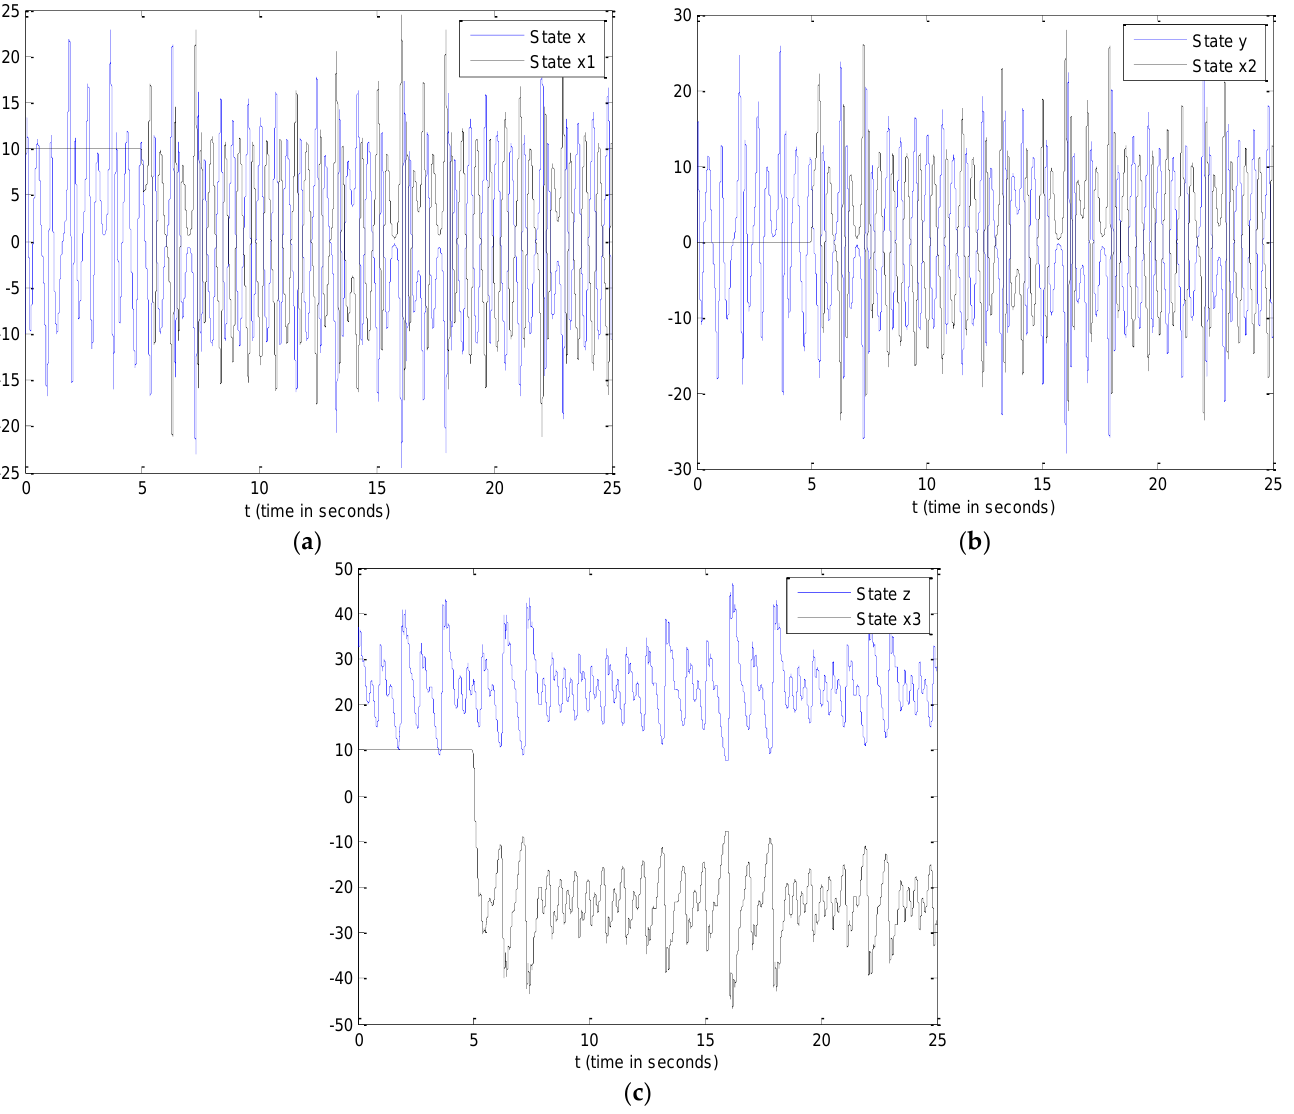
Figure 13. Time response plots of anti-synchronized states of master and slave with 𝛼 𝑖 = 0.9, 𝑖 = 1,2,and 3 , and time delay 𝜏 = 5 s : ( a ) First state (𝑥 − 𝑥1) of master and slave; ( b ) second state (𝑦 − 𝑥2) of master and slave; ( c ) third state (𝑧 − 𝑥3) of master and slave.